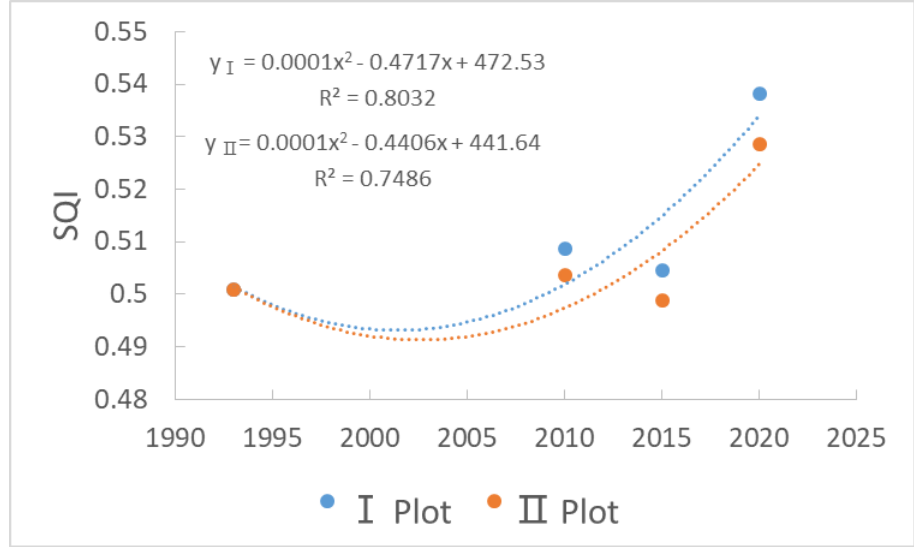
Figure 7. Soil Quality Index dynamics.